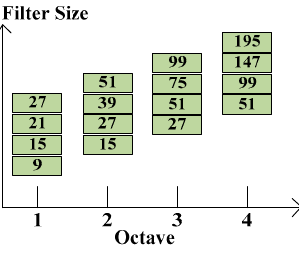
Figure 4. Various side lengths for four different octaves.